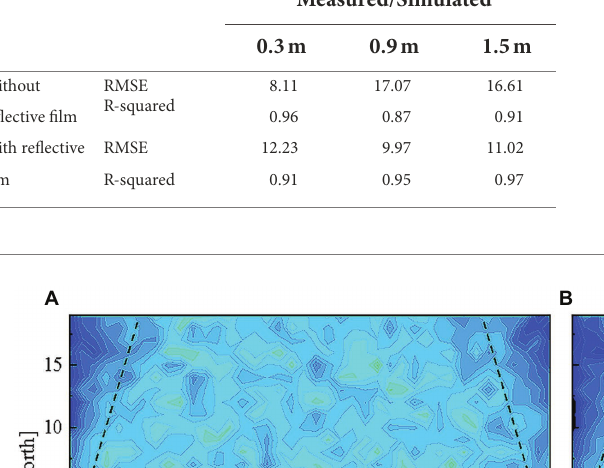
TABLE 2 Root mean square error (RMSE) and R-squared of the simulated and measured data of average solar radiation intensity at different heights (0.3/0.9/1.5 m).